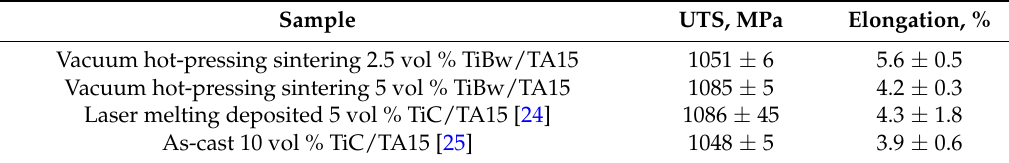
Table 5. Room-temperature tensile properties of the TiB(TiC)/TA15 composites.